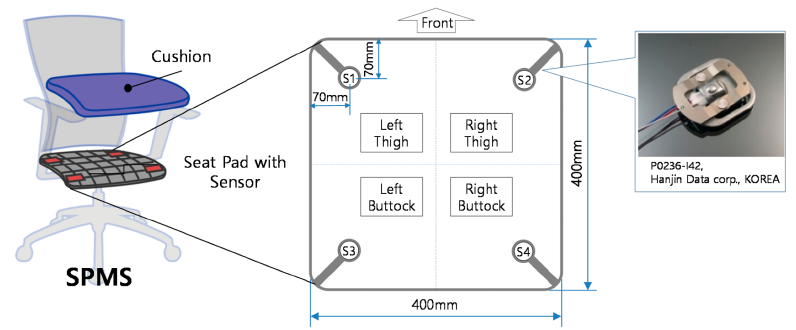
Figure 1. Arrangement and structure of the load cells in the SPMS. Retrieved from